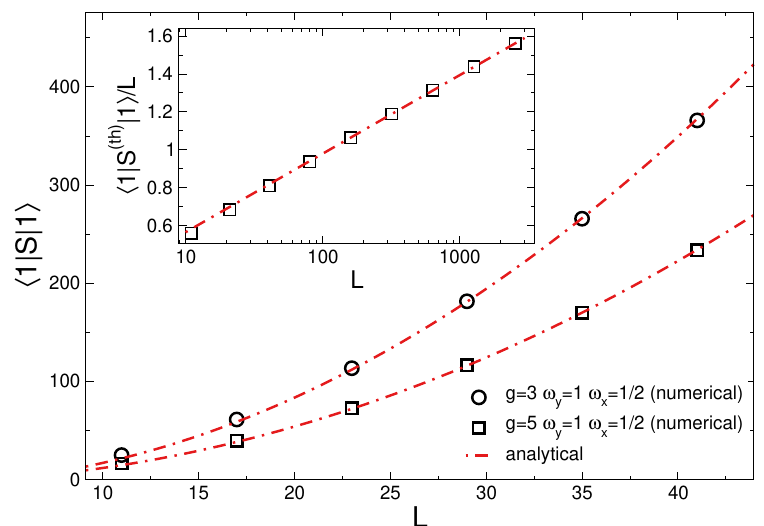
Figure 3: Flat-vector expectation value 〈 1 | (cid:83) | 1 〉 of the spin-spin correlator in the or- dered phase of the QSM. The behaviour as 〈 1 | (cid:83) | 1 〉 ∝ L 2 is clearly visible. The dashed-dotted lines are the theory predictions (39). We show results for different aspect ratios ω , ω (see Fig. 1) and quantum coupling g . The inset show the con- y x tribution of the thermodynamic part of the correlator (cid:83) ( th ) (cf. (18)) for g = 5. The behaviour as 〈 1 | (cid:83) ( th ) | 1 〉 ∝ L ln ( L ) is clearly